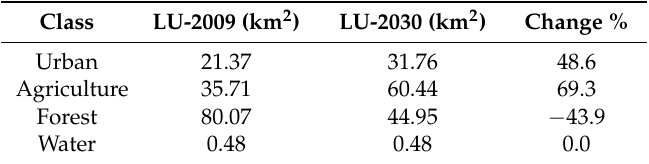
Table 3. Land-use changes between 2009 and 2030 in the Bogor Basin, upstream of the Ciliwung Basin.